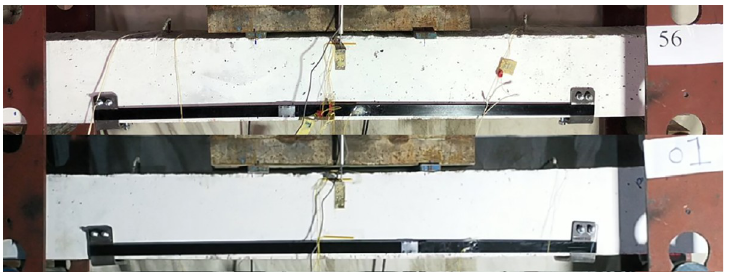
Fig 23. Vertical alignment of the channels of beam 56 and beam